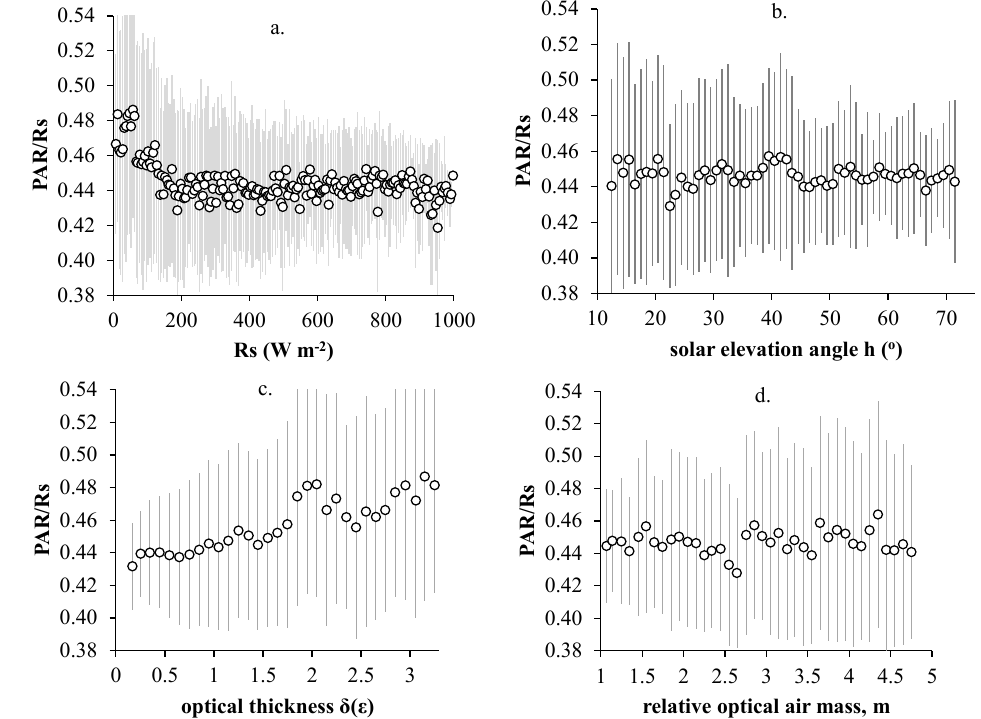
Figure 6. Averages and standard deviations of the PAR/Rs hourly ratio with the variation of ( a ) the magnitude of Rs grouped in 5 Wm − 2 bin classes, ( b ) the solar elevation angle h grouped in 1o bin classes, ( c ) the optical thickness h grouped in 0.1 bin classes, and ( d ) the relative optical air mass m grouped in 0.1 bin classes.